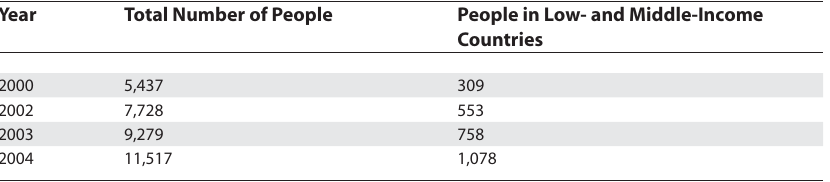
Table 1. Number of People Actively Involved in Cochrane Collaborative Review Groups Year Total Number of